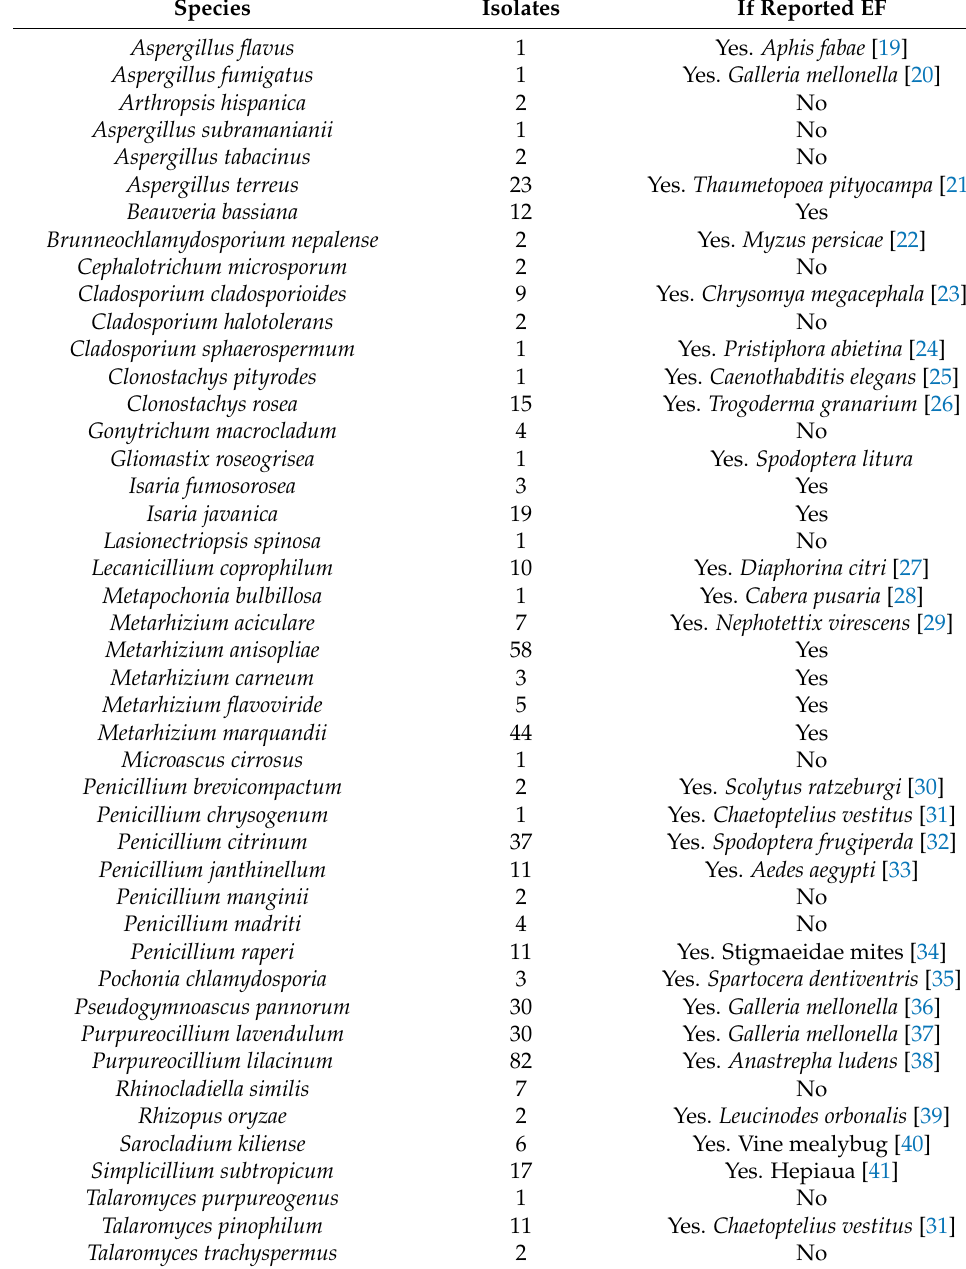
Table 1. Information of fungal species